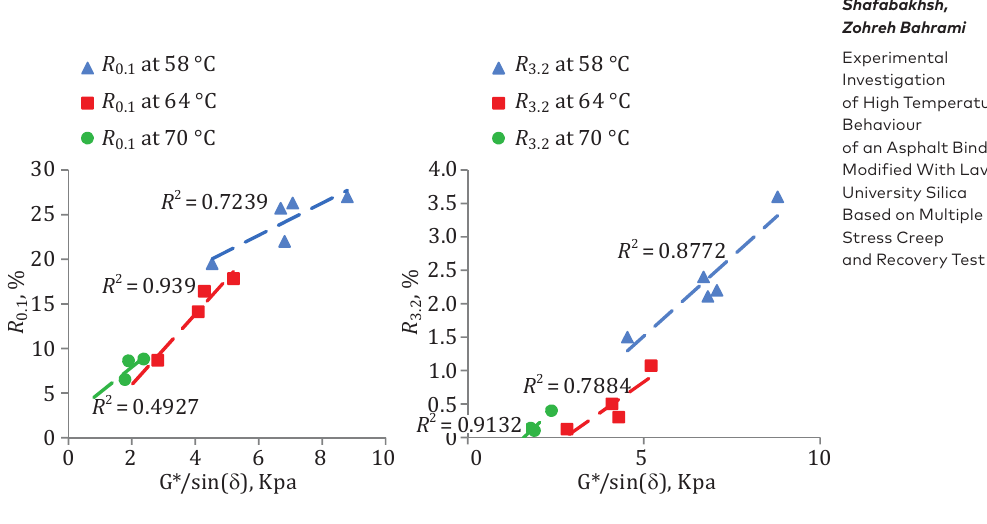
Figure 20. Linear correlation between G*/sin( d ) and